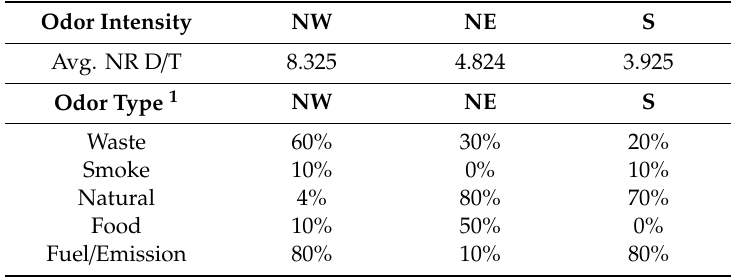
Table 3. Odor intensity and frequency of category by